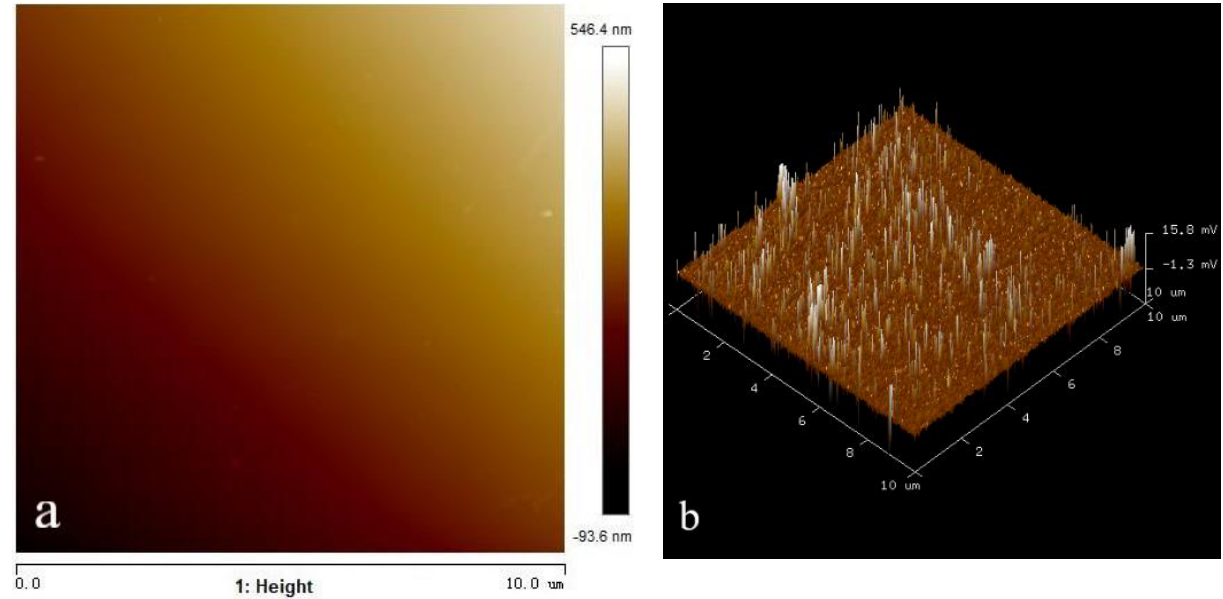
Figure 11. AFM morphology of wolframite grinding disc. ( a ) height ( b ) 3D.